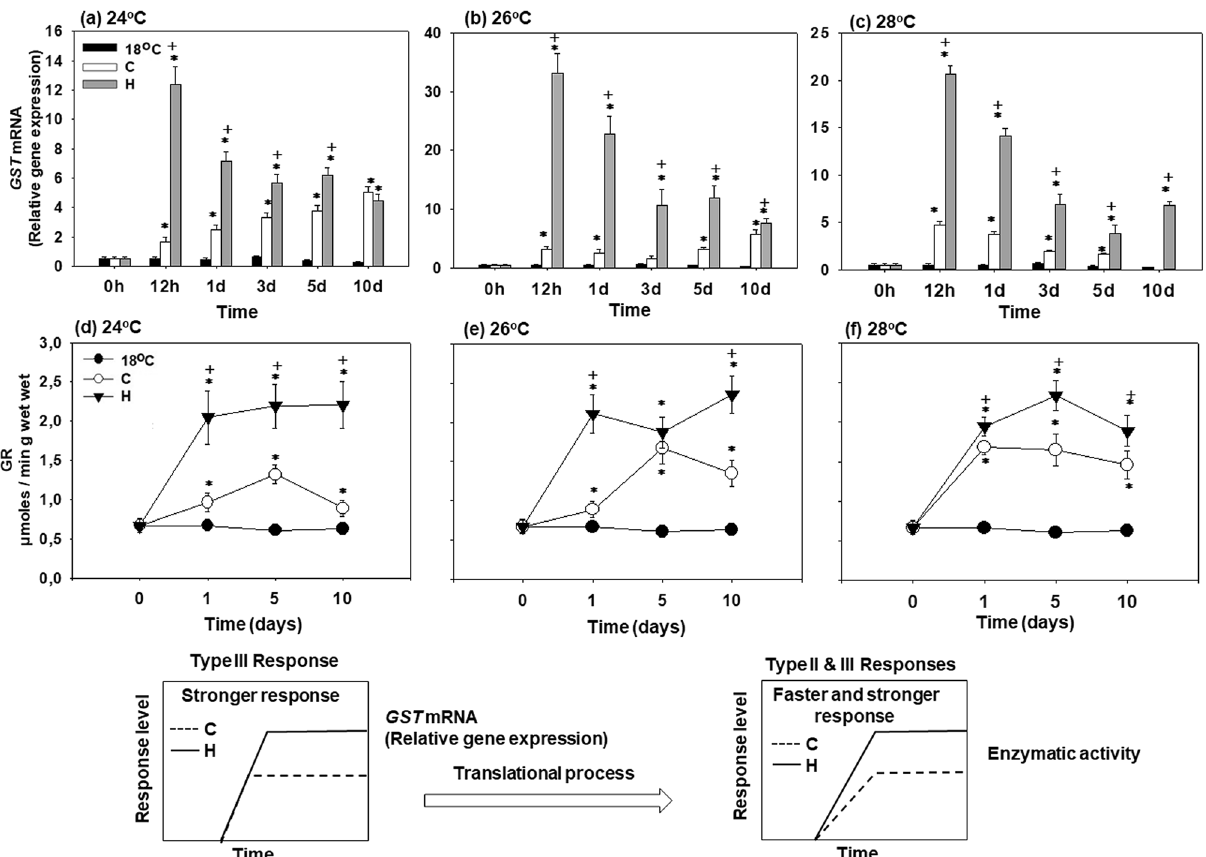
Figure 5. Changes in the relative GST mRNA levels [Type III (stronger) response] and GR enzymatic activity [Type II & III (faster and stronger) responses] in the mantle of heat hardened (H) and non-hardened (C) Mytilus galloprovincialis when exposed to 24 °C ( a , d ), 26 °C ( b , e ) and 28 °C ( c , f ) compared to control at 18 °C. Values are means ± SD, n = 8 preparations from different animals. * p < 0.05 compared to day 0, + p < 0.05 compared to non-hardened (C)